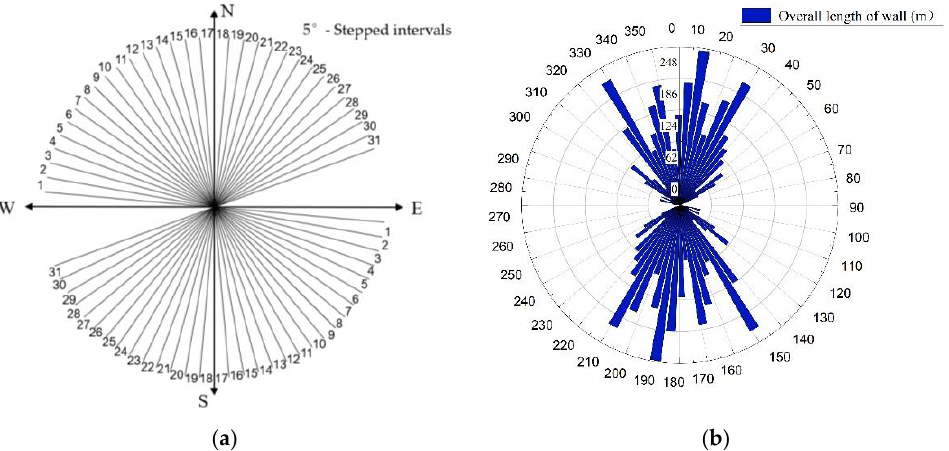
Figure 6. Statistic method and results of length of the Wall. ( a ) Partition map of the north and south facades of the Great Wall. ( b ) Length of the Wall with various azimuths. Table 1. Sapping quantity statistics of the north and south facades of the Great Wall in